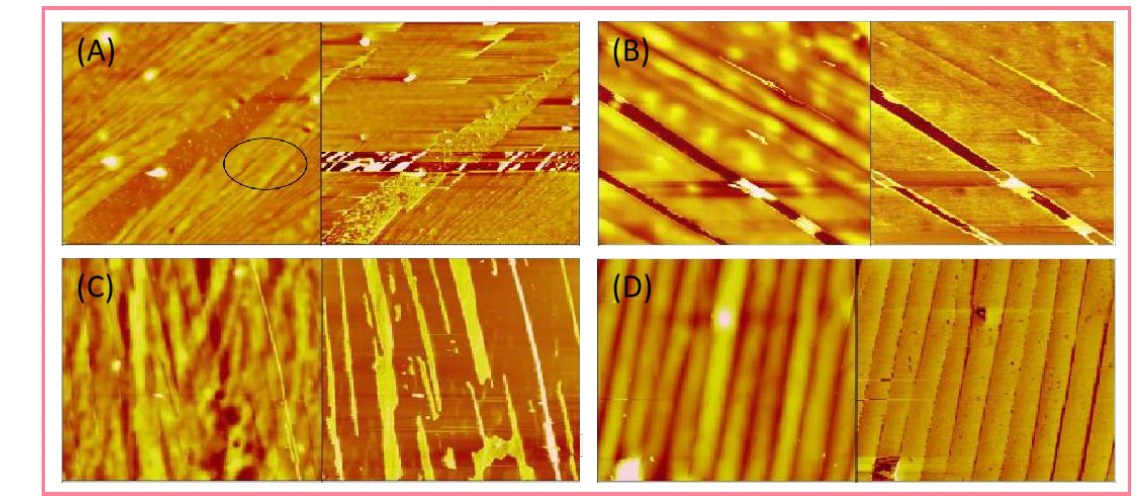
Figure 6. AFM topography and phase image of PPSA at different concentrations. ( A ) 0.5 g/L. ( B ) 0.7 g/L. ( C ) 1 g/L. ( D ) 1.5 g/L [132]. ( B ) 0.7 g/L. ( C ) 1 g/L. ( D ) 1.5 g/L